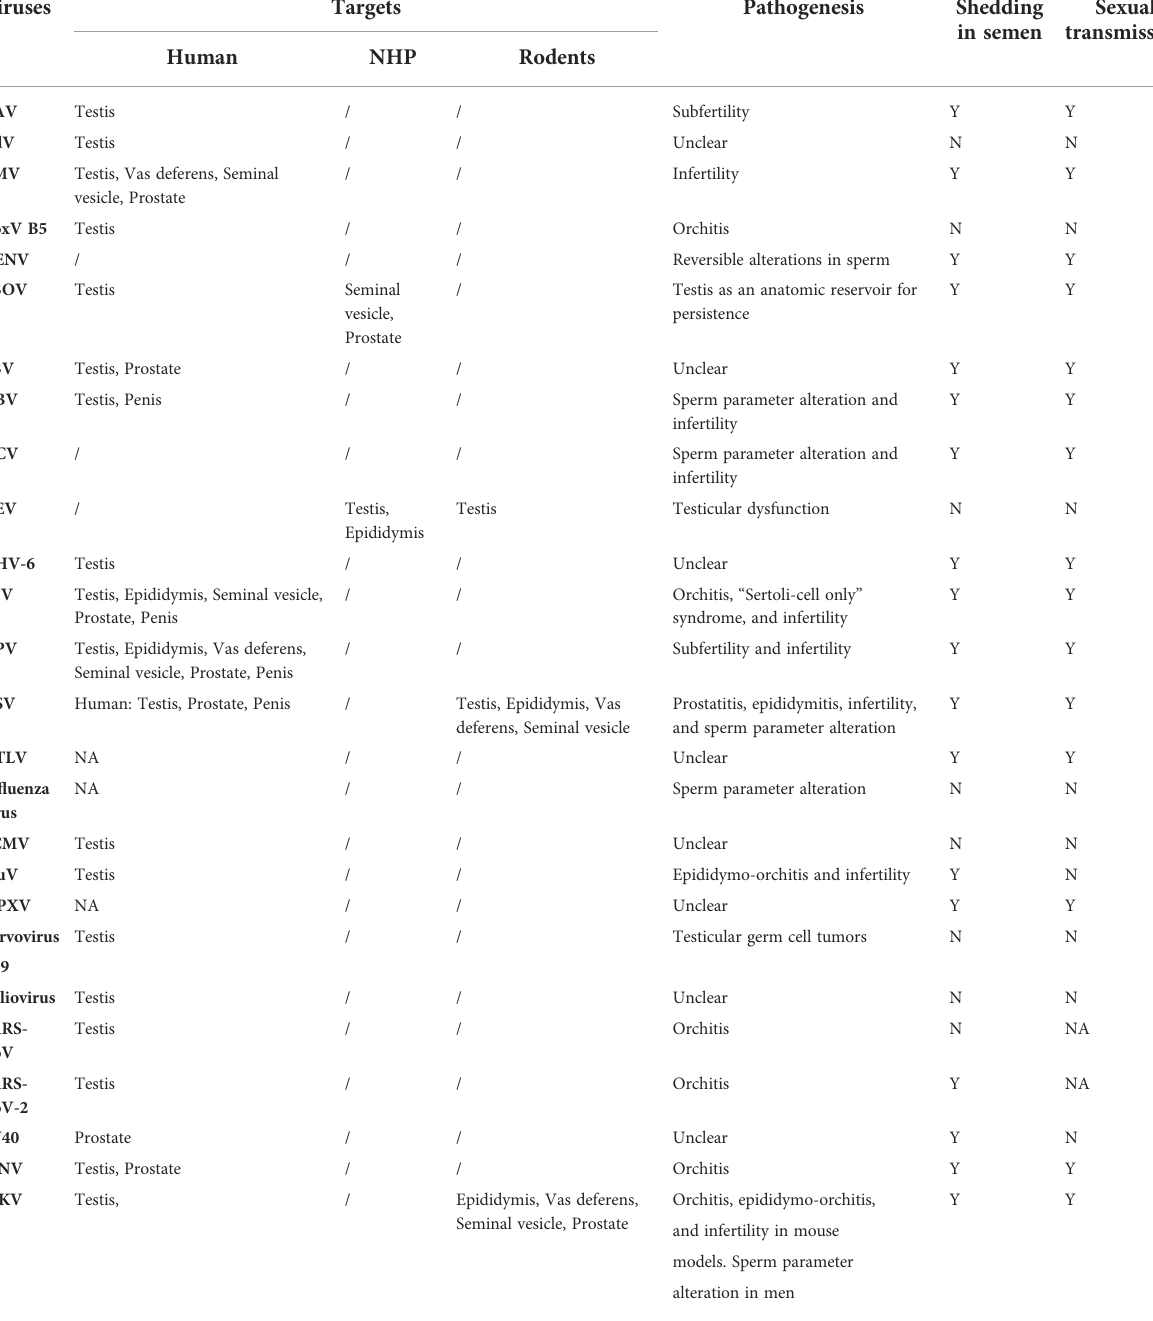
TABLE 1 Major viruses in the male reproductive system. Viruses